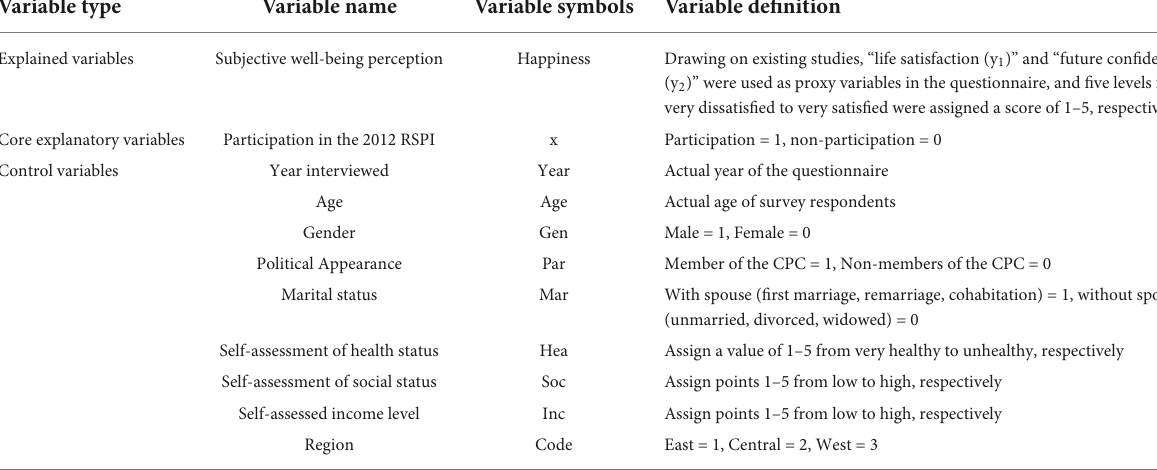
TABLE 1 Variable definition table ( N = 43,700).